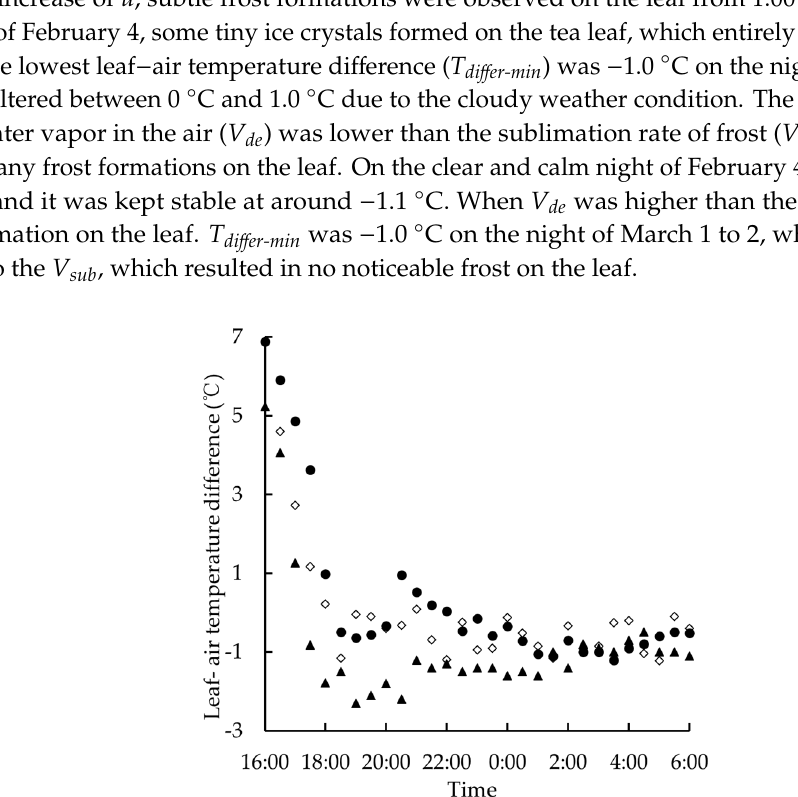
Figure 5. T differ in the three observation nights, where ( ▲ ), ( ● ), ( ◇ ) is represented for the dates of February 4 to 5, March 1 to 2, and January 26 to 27, 2016, February 4 to 5, March 1 to 2, and January 26 to 27, 2016, respectively.